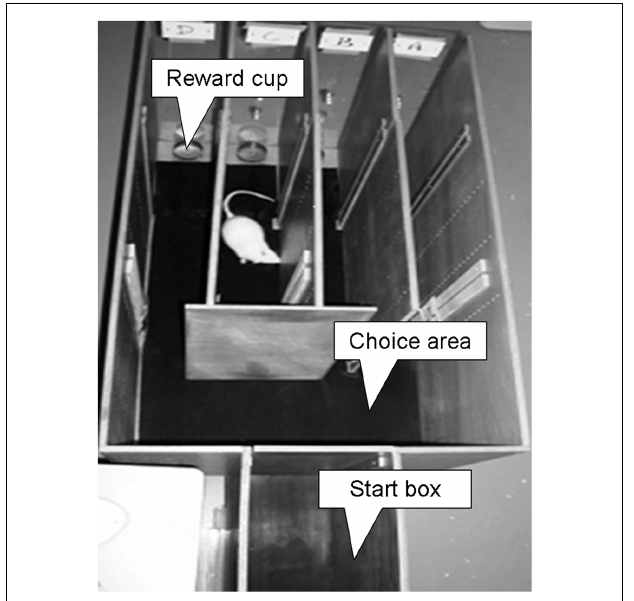
FIGURE 2 |The four-arm box maze model (RGT rewardorquinine ): top view of the maze with start box, choice area, and four arms with reward cups. When an animal has made a choice for a particular arm, this arm is closed off with a slide to prevent the animal from returning to the choice area before investigation of the reward cup.